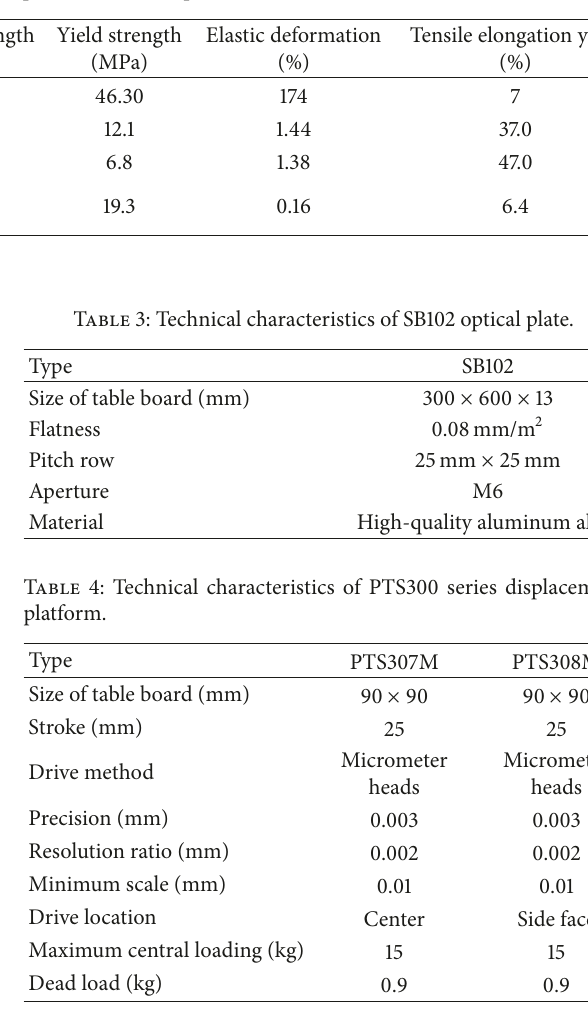
Table 1: Mechanical properties of each component and Al-Kapton membrane [14].